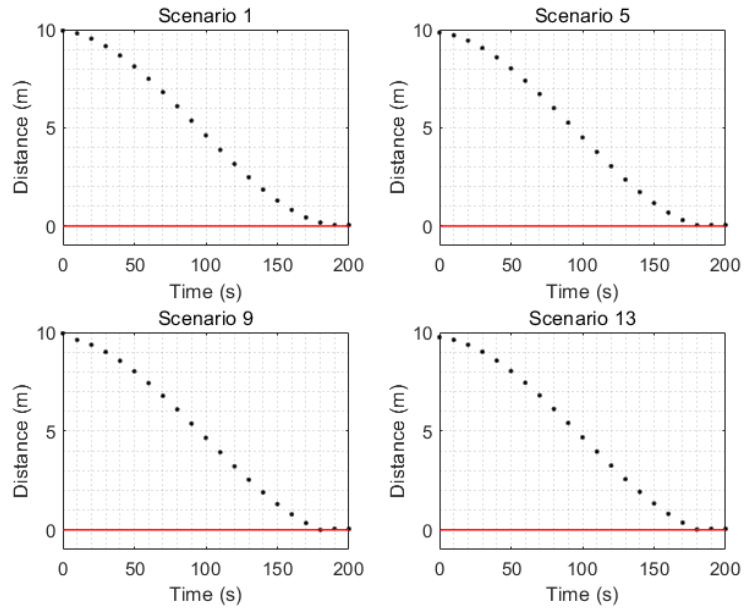
Figure 11. Safe distance limit: the dashed line is the safety limit, and a negative value indicates collision of four scenarios.